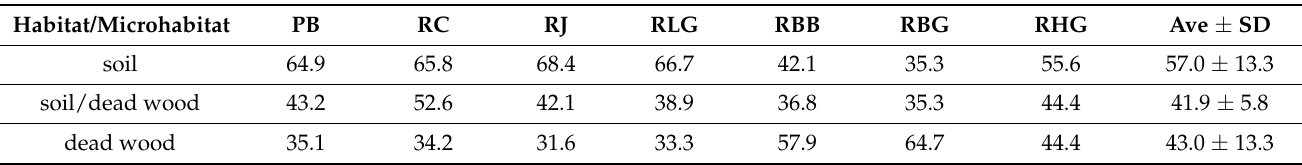
Table 3. Percentage of species with different habitat preferences in examined locations. PB—Białowie˙za Primeval